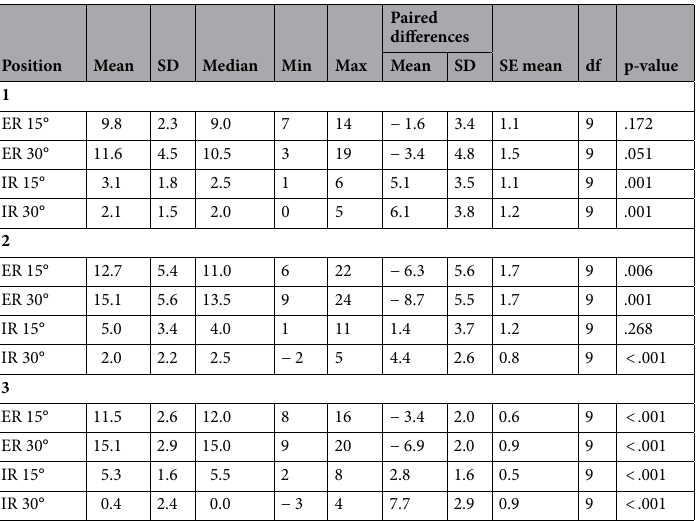
Table 2. Descriptive analysis and outcomes of t-tests for RN testings ( in mm ). ER external rotation, IR internal rotation, SD standard deviation, min minimum, max maximum, SE mean standard error of the mean, df degrees of